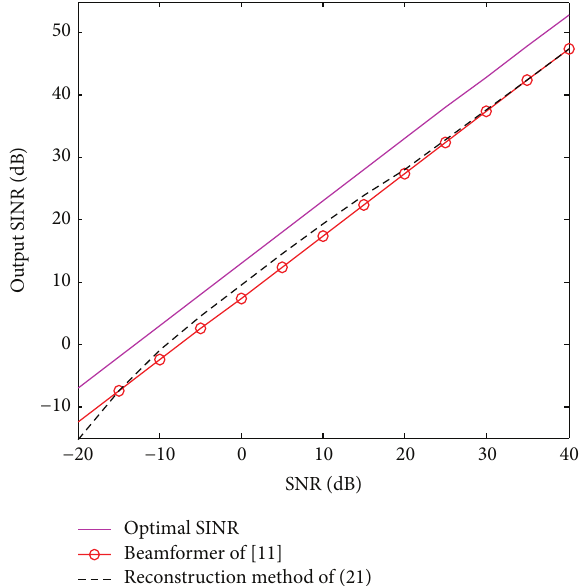
Figure 15: Output SINR versus the input SNR with different recon- struction